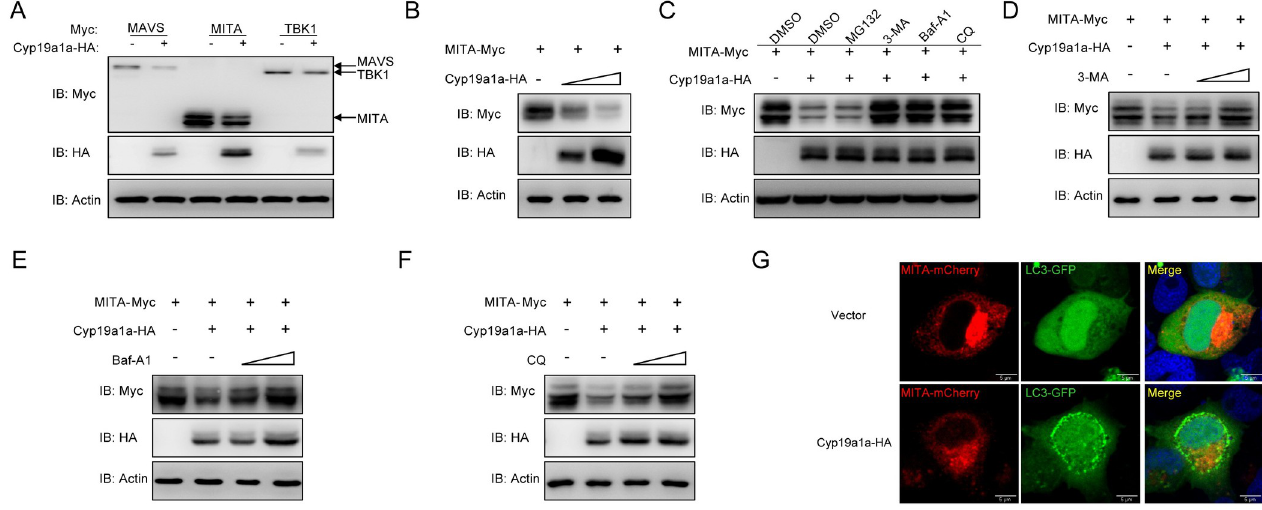
Fig 5. Cyp19a1a mediates degradation of MITA via the autophagy pathway. (A and B) EPC cells were co-transfected with 1 μ g Cyp19a1a-HA and 1 μ g empty vector, MAVS-Myc, MITA-Myc, or TBK1-Myc (A), or 1 μ g MITA-Myc plus Cyp19a1a-HA (1 or 2 μ g) or 2 μ g empty vector (B) for 24 h. The cell lysates were subjected to IB with anti-Myc, anti-HA, and anti- β -actin Abs. (C) EPC cells were co-transfected the indicated plasmids. At 18 h post-transfection, the cells were treated with DMSO, MG132 (20 μ M), 3-MA (2 mM), Baf-A1 (100 nM), or CQ (100 μ M) for 6 h. The cell lysates were subjected to IB with the indicated Abs. (D-F) EPC cells were co-transfected the indicated plasmids. At 18 h post-transfection, the cells were treated with 3-MA (1 or 2 mM), Baf-A1 (50 or 100 nM), or CQ (50 or 100 μ M) for 6 h. Then, the cells were harvested for IB with the indicated Abs. (G) EPC cells were co-transfected with 1 μ g Cyp19a1a-HA or pCMV-HA plus 1 μ g MITA-mCherry and 1 μ g LC3-GFP. After 24 h, the cells were fixed and observed by confocal microscopy. Red signals represent overexpressed MITA, green signals represent overexpressed LC3 or GFP-LC3 positive autophagosome accumulation (original magnification 63 × ; oil immersion objective). Scale bar, 10 μ m. All experiments were repeated for at least three times with similar